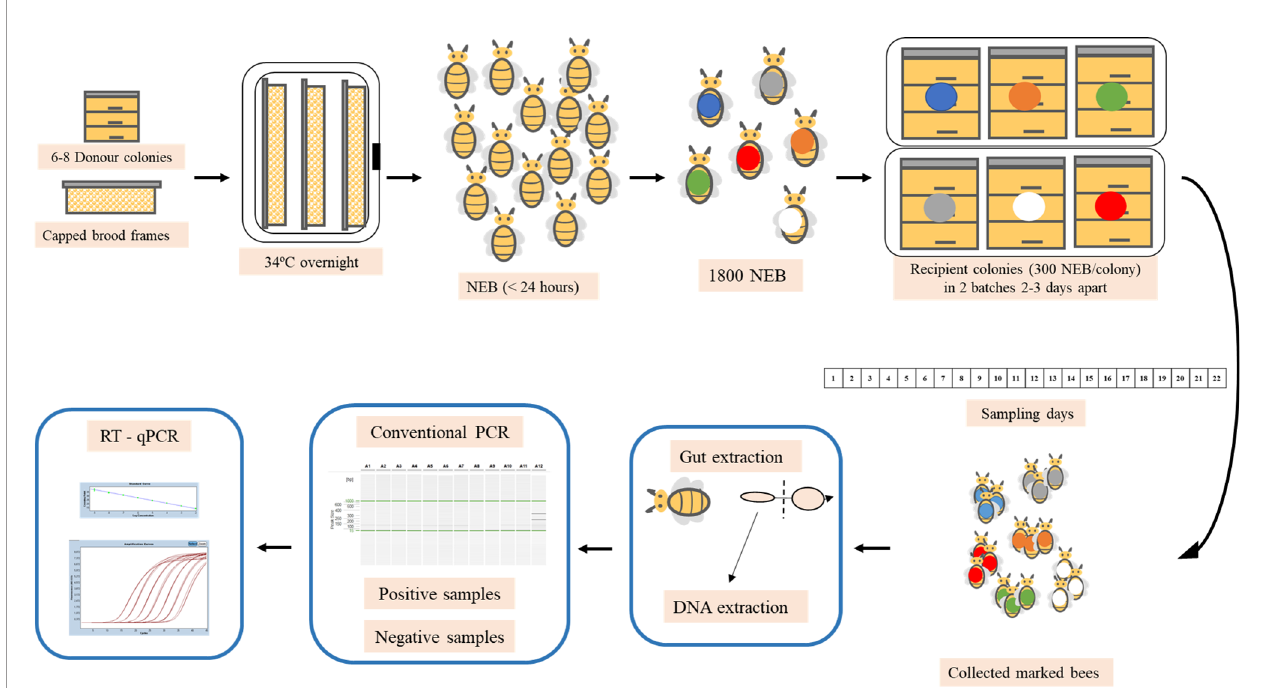
FIGURE 1 | Experimental design of spring and autumn trials. Capped brood frames were taken from a donor apiary and placed overnight in an incubator and the following day, the newly emerged bees (NEB) were marked and placed in the selected recipient colonies. Marked bees were collected every day and processed in the laboratory. The midgut was removed from each bee and molecular analysis were carried out to detect N. ceranae infection and whenever the samples were positive, RT-qPCR was conducted to quantify the parasitic